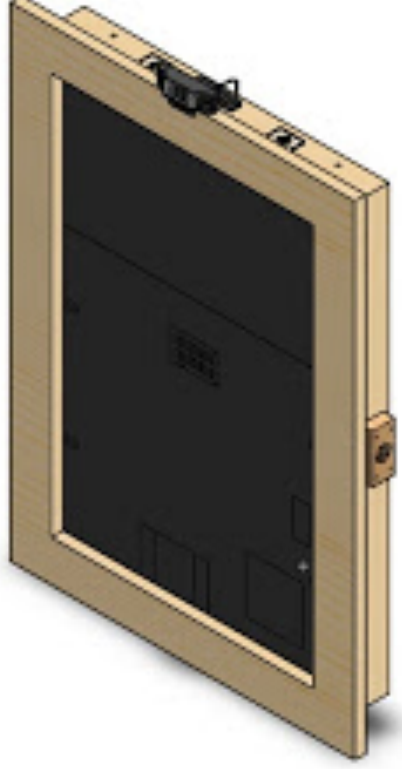
Figure 3. Smart mirror SolidWorks